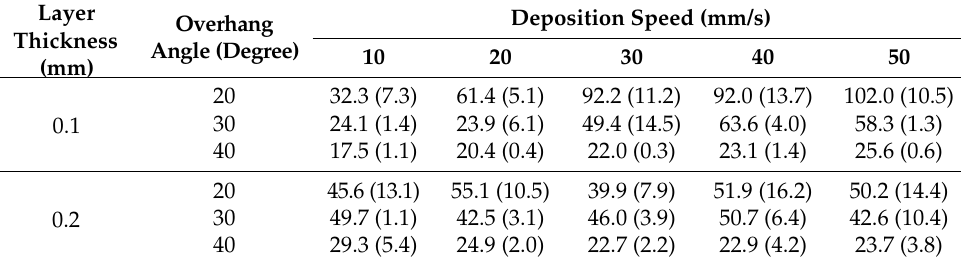
Table 5. Mean value (standard deviation) of measured surface roughness.